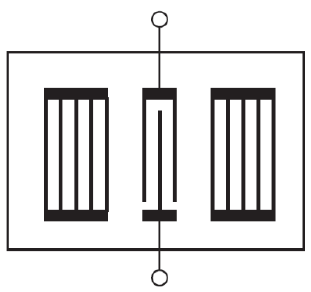
Figure 7. One-port SAW resonator with gratings, adapted with permission from [4]. 240 Spurious BAW modes are also a possible source of reduced performance. Among 241 them, so-called deep bulk acoustic waves (DBAW) can be generated by the input IDT, then 242 propagate in the volume of the piezoelectric layer, get reflected at the bottom face, and then 243 propagate back to the receiving IDT. Surface skimming bulk waves (SSBW) and other leaky 244 waves are also examples of possibly interfering (or sometimes alternating) waves 245 [31]. 246 Waves undergoing reflections on the device sides or bottom can be limited by sand- 247 blasting the bottom surface or biasing the sides in order to avoid constructive reflections 248 travelling back to the IDTs. Other interfering waves such as SSBW need, for intrinsic good 249 design, to take into account both longitudinal and shear acoustic waves.